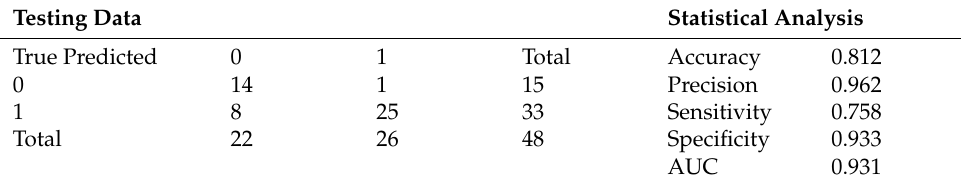
Table 4. Confusion matrix for the “3-Day”